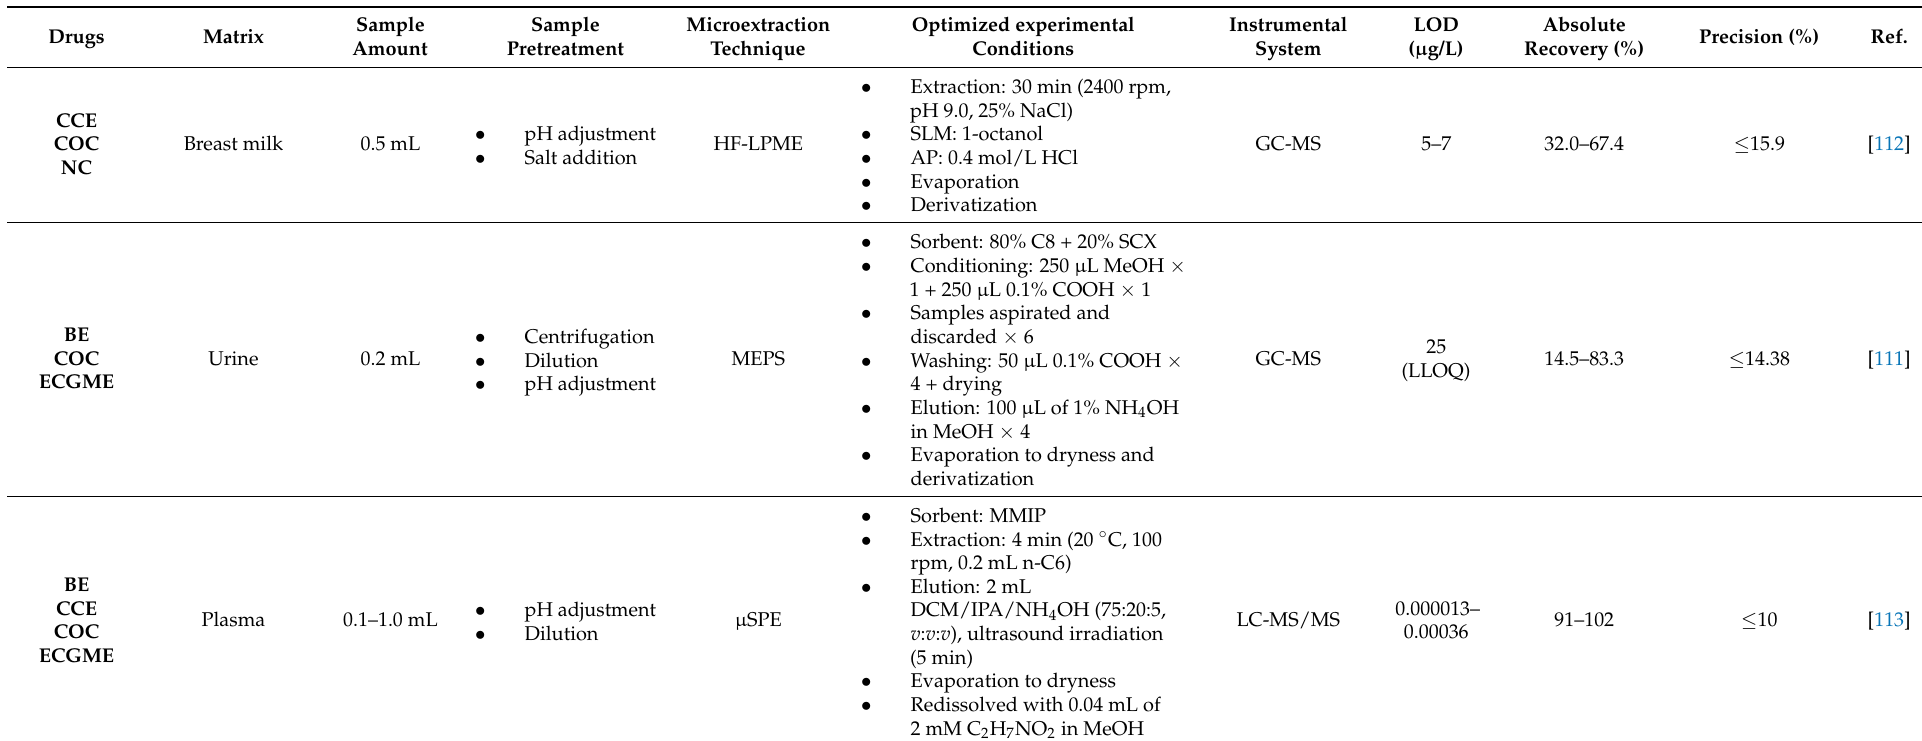
Table 2. Microextraction-based approaches for the analysis of cocaine and related substances in the forensic